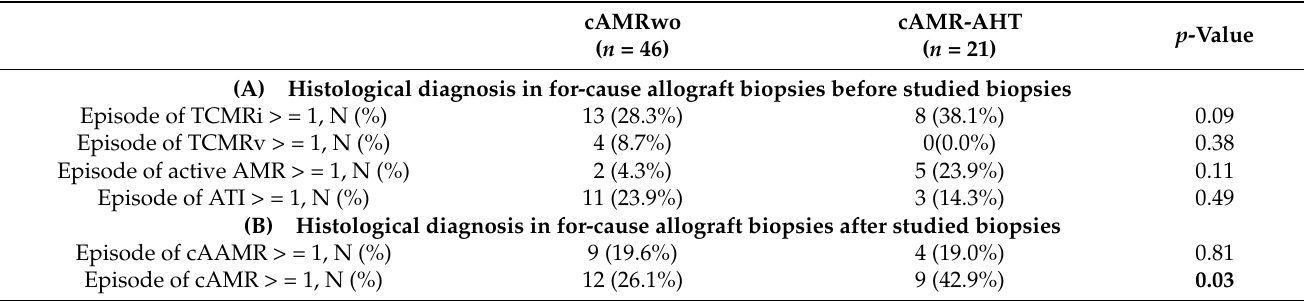
Table 3. Comparison of pathological features between